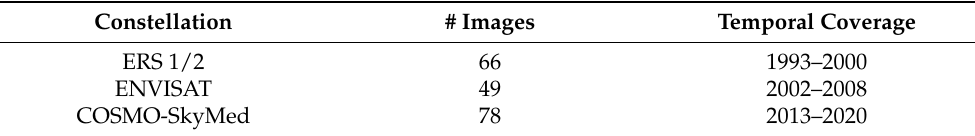
Table 1. Main characteristics of used synthetic aperture radar (SAR) images. Constellation #